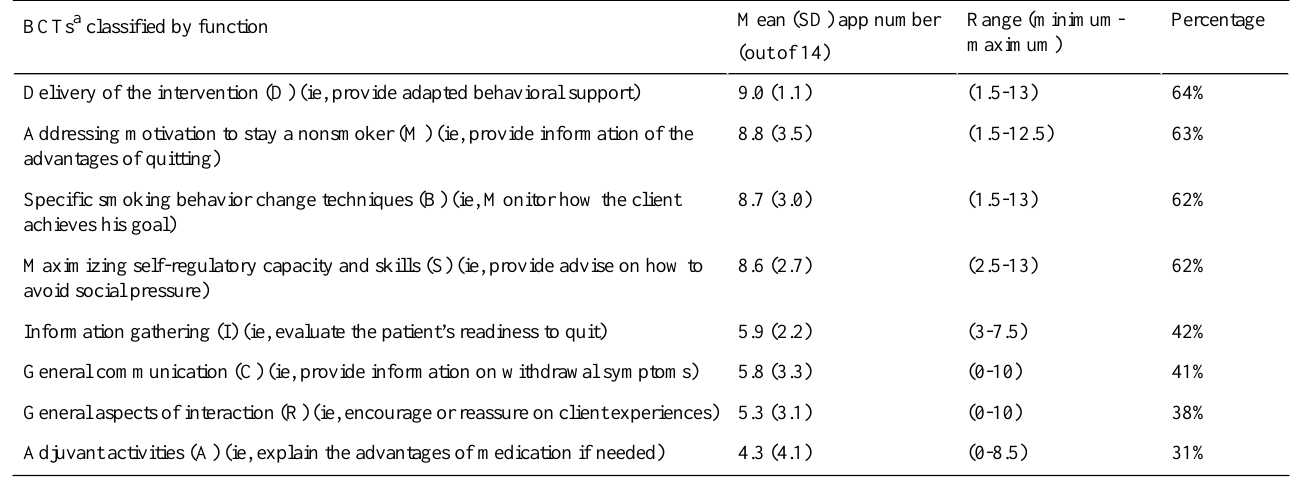
Table 3. Behavioral and cognitive techniques classified by function in the smoking cessation apps studied, according to the taxonomy of Michi et al